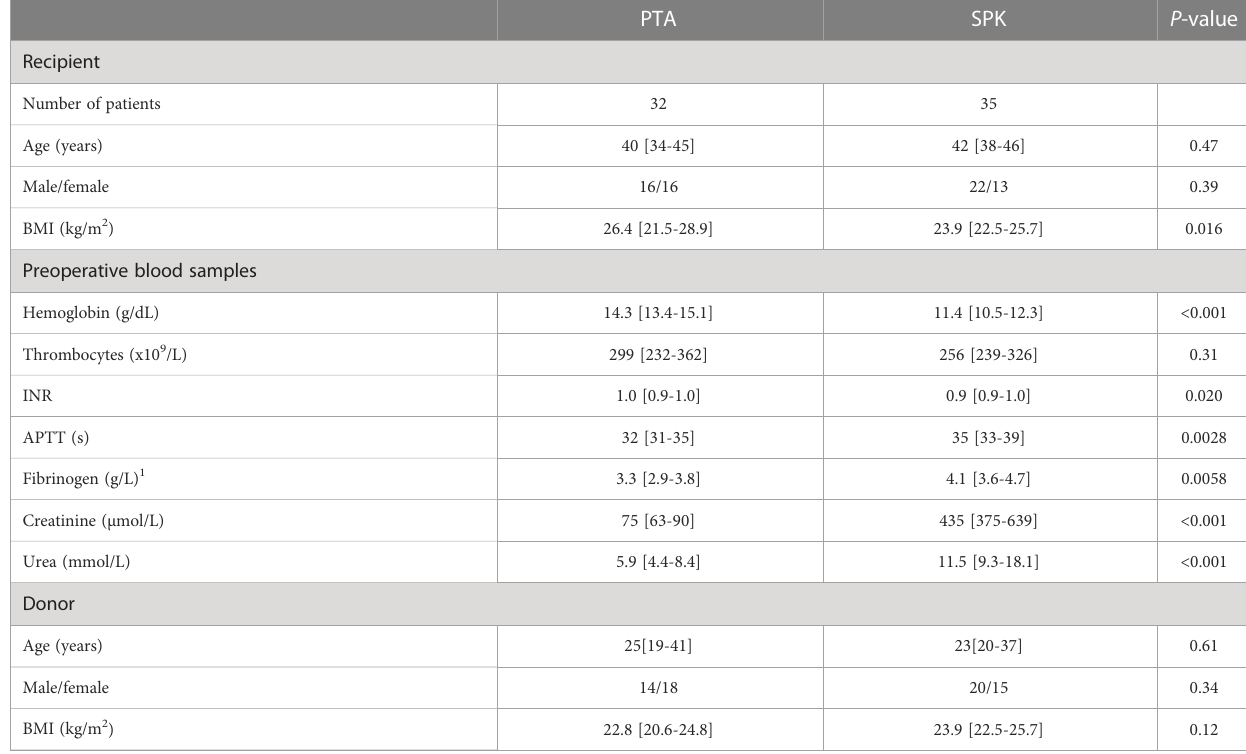
TABLE 1 PTA and SPK recipient and donor characteristics and perioperative data. PTA SPK P